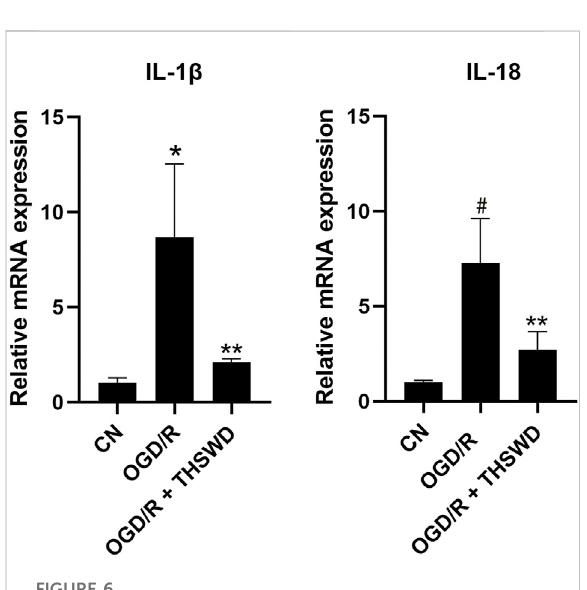
FIGURE 6 mRNA expression of IL-1 β and IL-18. Notes: * p < 0.05, # p < 0.01 vs. Sham group; ** p < 0.05 vs. I/R